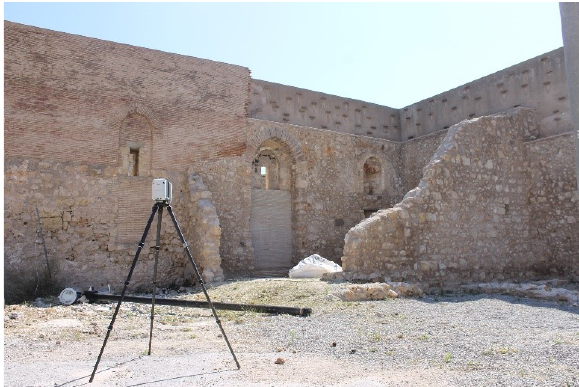
Figure 5. Laser scanner survey of the internal courtyard.